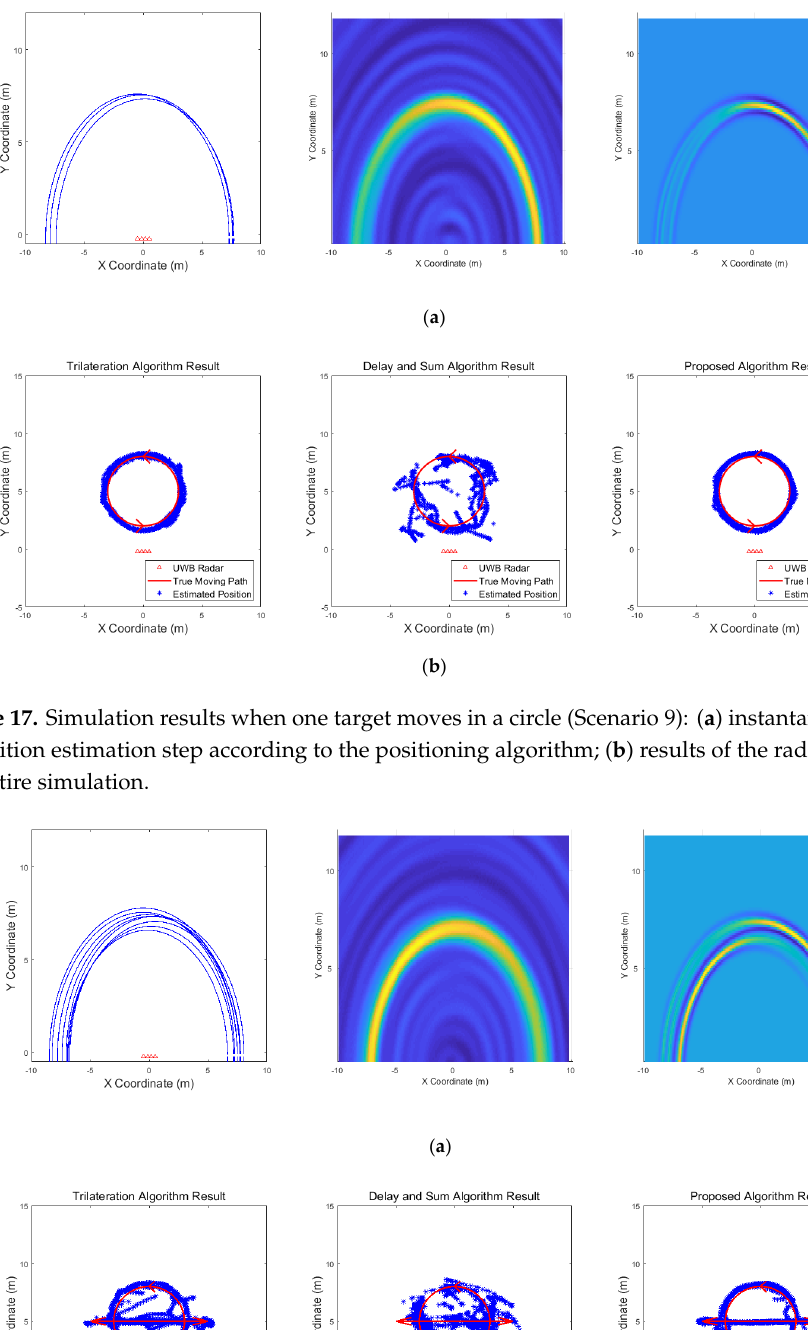
Figure 16. Simulation results when two targets move and one target stands (Scenario 8): ( a ) instantaneous results of position estimation step according to the positioning algorithm; ( b ) results of the radar system for the entire simulation.